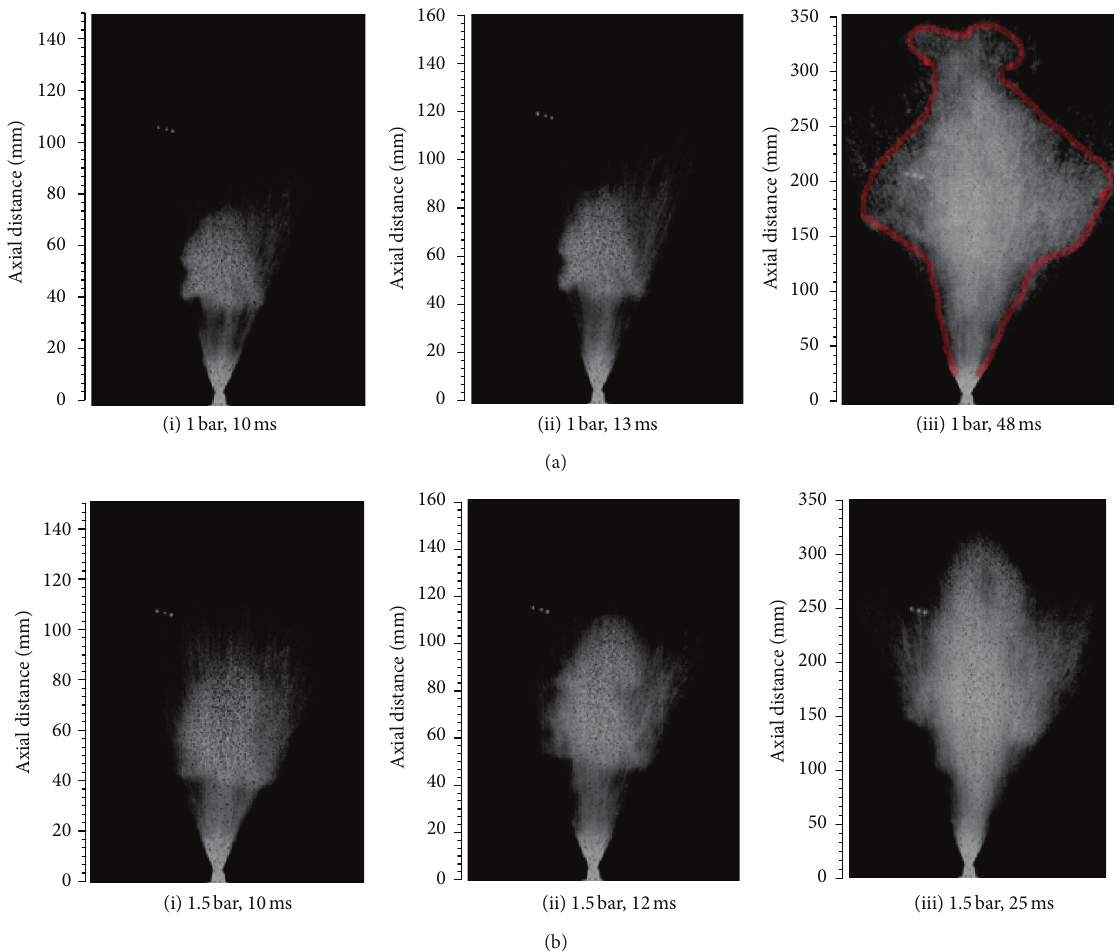
Figure 2: (a) Images of developing spray at 1bar gauge pressure and 90 ∘ C service temperature. (b) Images of developing spray at 1.5 bar gauge pressure and 90 ∘ C service